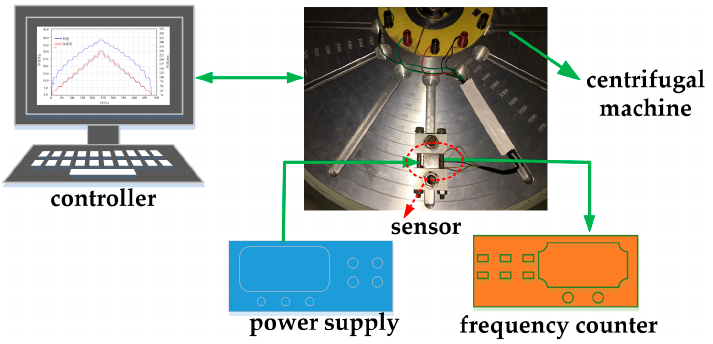
Figure 21. Static measurement system under ±100 g acceleration.